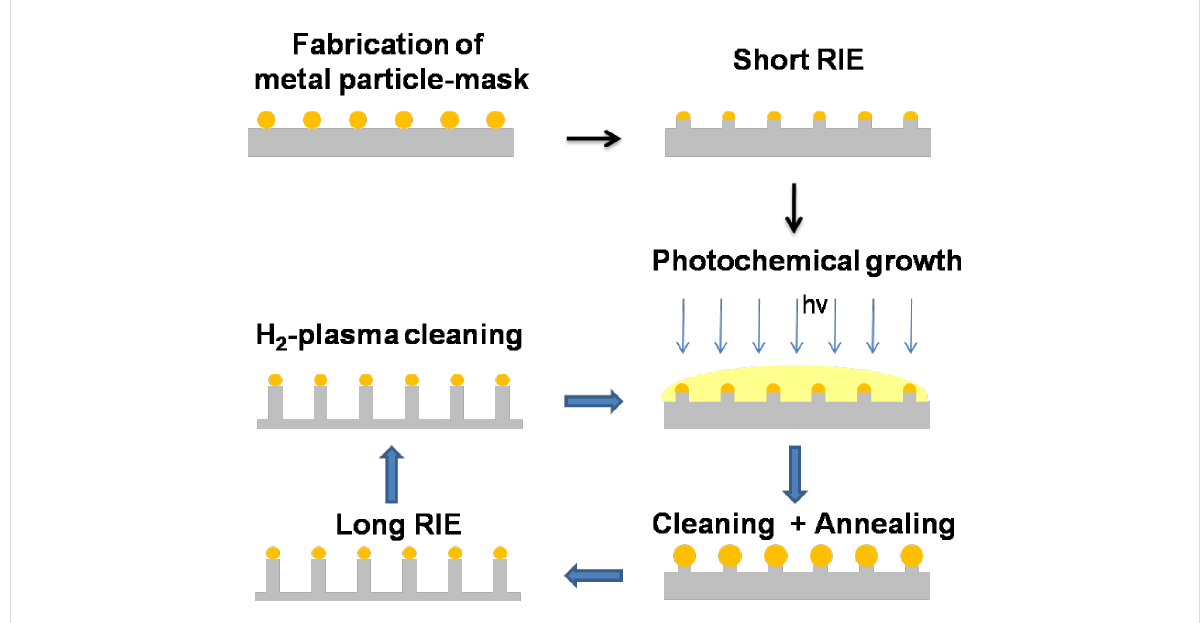
Figure 4: Schematics of fabricating nanopillars by applying Au NP as masks, which are repeatedly re-grown by an UV light activated photochemical process thus compensating their erosion due to previous etching.